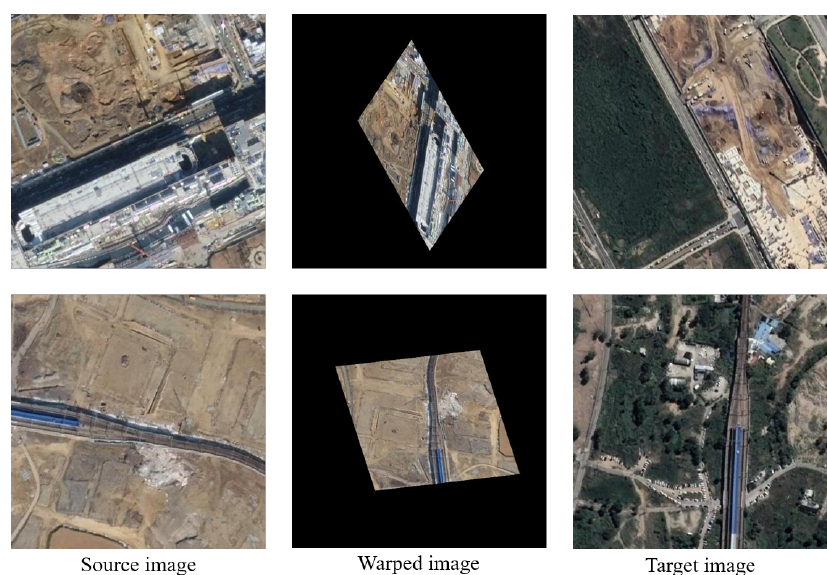
Figure 14. Failure cases, which are largely changed areas. Since the changed area is too large, it fails